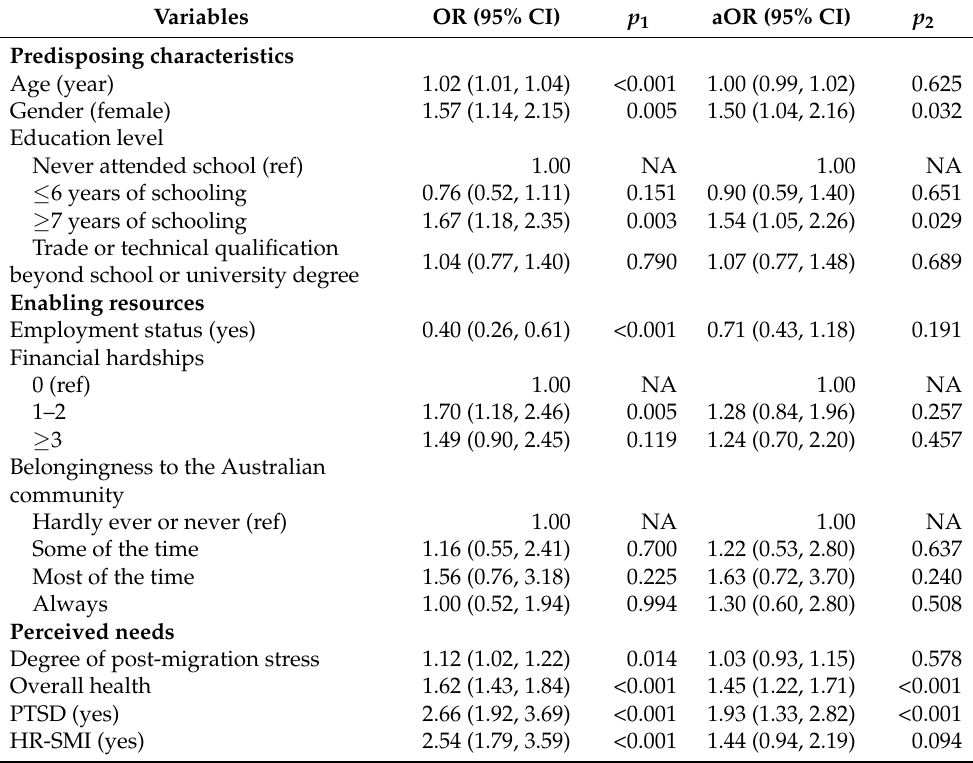
Table 3. Factors associated with the frequency of MHS contacts among resettled humanitarian